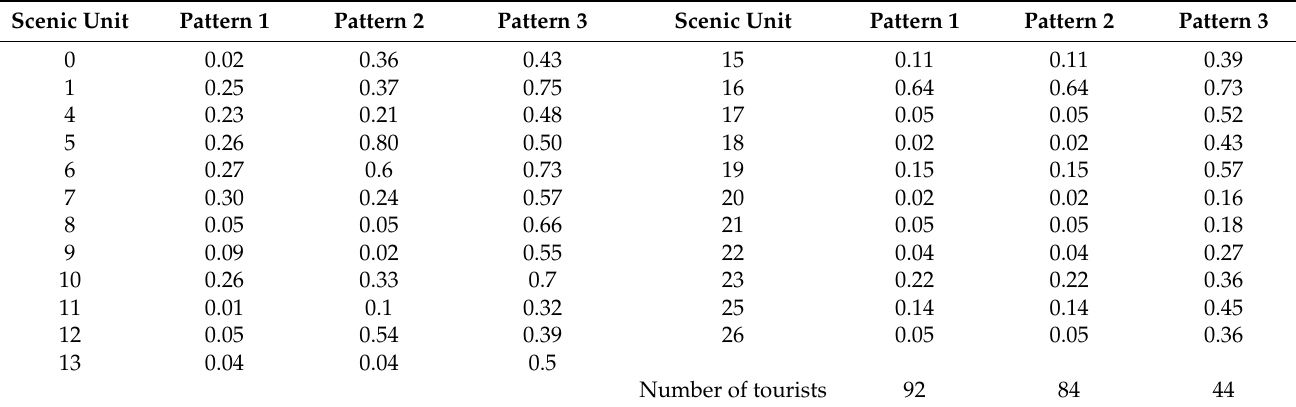
Table 2. Three tour patterns and the visitation probabilities.